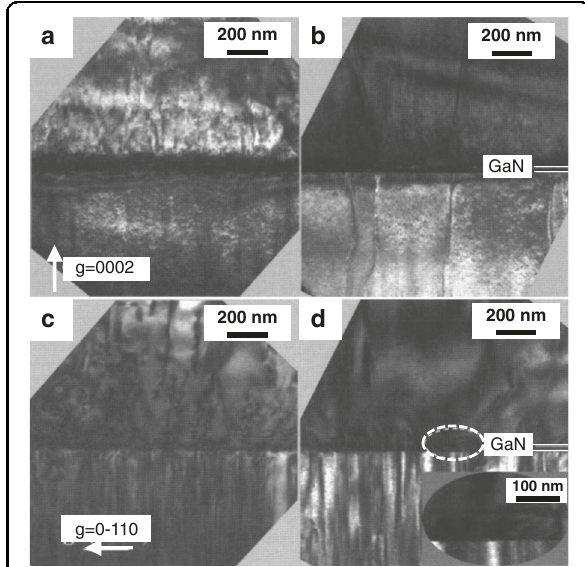
Fig. 2 Cross-sectional TEM images for the AlGaN layers grown on AlN/sapphire templates. Samples without ( a , c ) and with ( b , d ) a 25 nm HT-GaN interlayer. a , b are measured with diffraction vector g = (0002) to image screw-component threading dislocations. c , d with g = (0 – 110) to image edge-component threading dislocations. The inset of Fig. 2 d is an enlarged image of the dislocation, corresponding to the dashed circle. Reprinted with permission from Jiang et al. 104